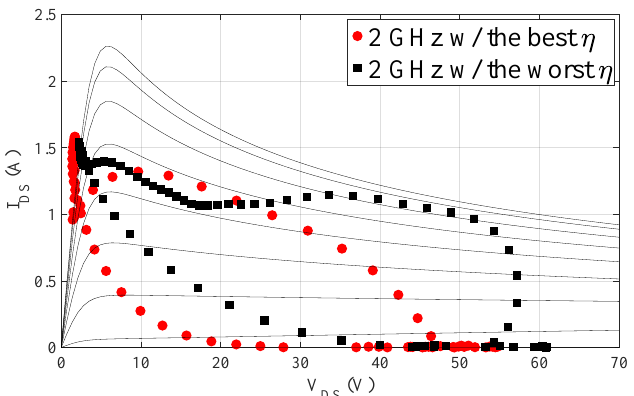
Figure 6. Comparison of the 2 GHz simulated intrinsic loadlines of the clockwise-loaded class- J PA with 21 dBm second-harmonic injection for the phases yielding the best (red) and worst (black) efficiencies.